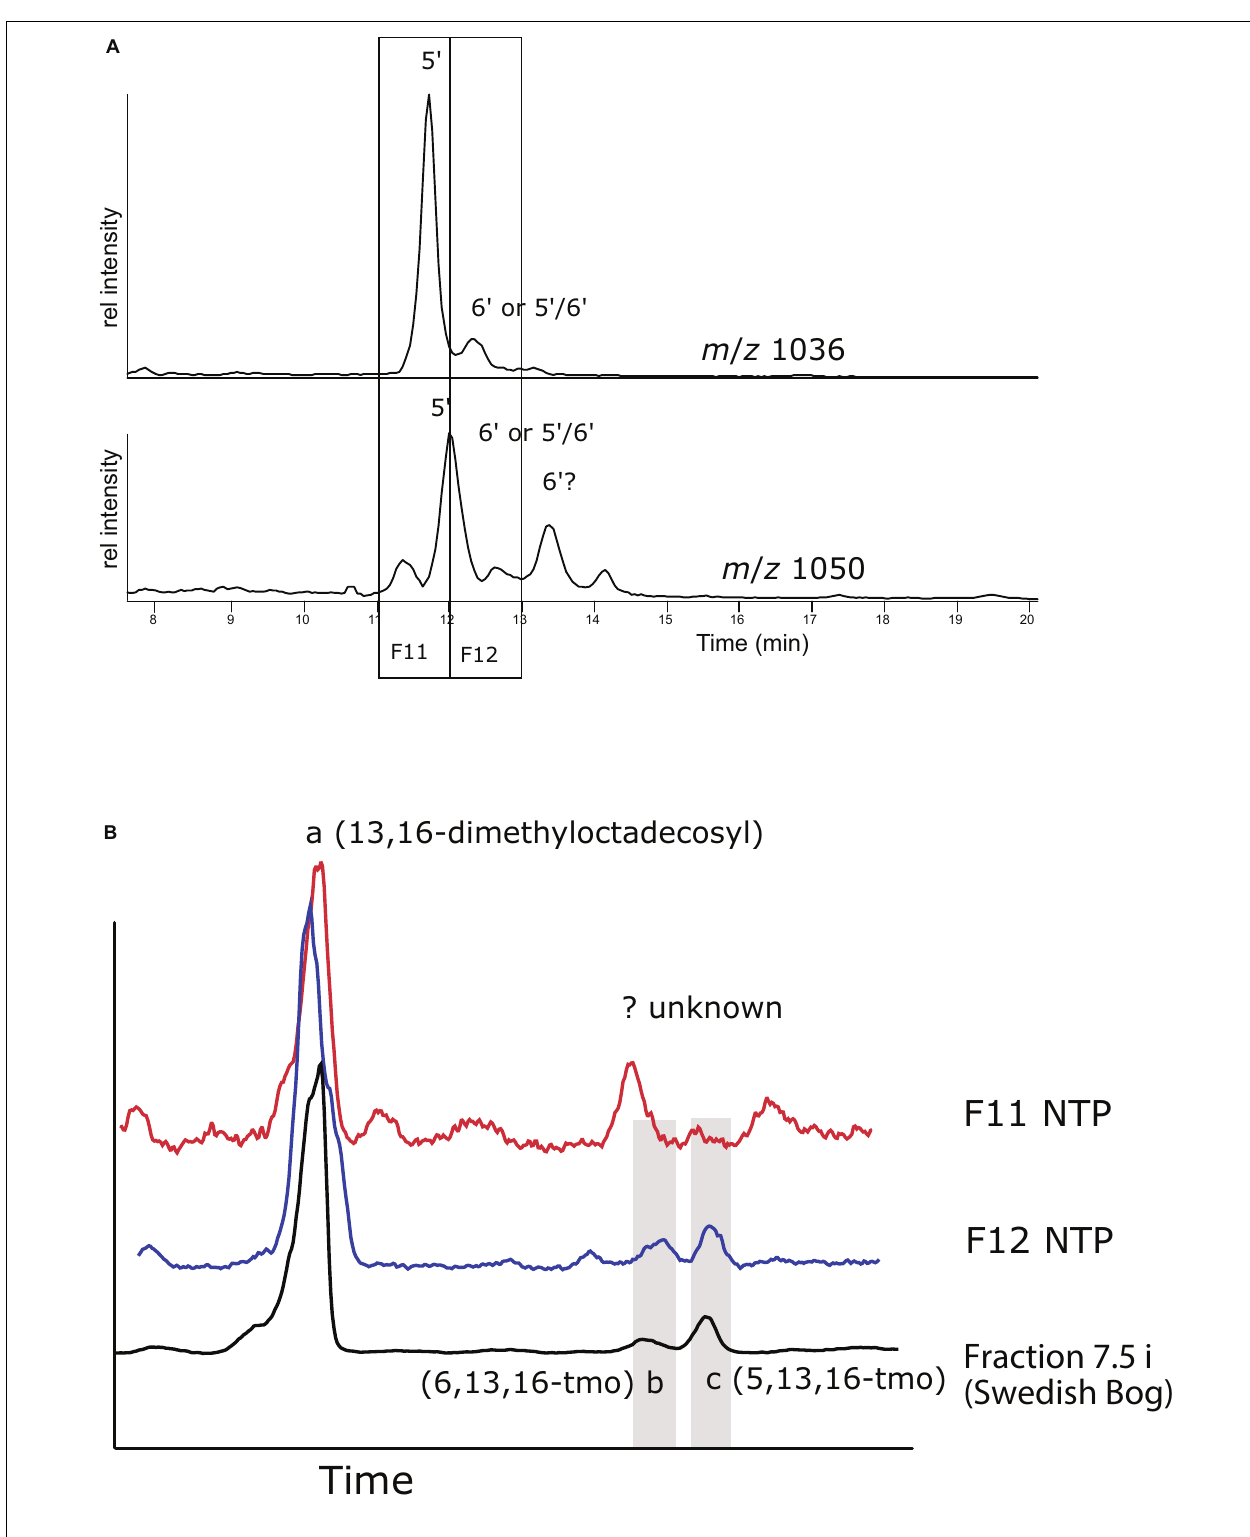
FIGURE 7 | (A) Reverse phase HPLC-MS ion chromatograms showing the distribution of m / z 1036 and m / z 1050 isomers in the NTP lake sediment extract. Numbers indicate the likely position of the methyl group on the isomers. (B) GC-MS total ion chromatogram (TIC) from ether cleaved and hydrogenated HPLC fractions eluting between 11–12 and 12–13 min, compared with the TIC of the 7.5 min fraction from the Swedish peat bog (cf. Figure 6 ). The positions of 5,13,16 (b)- and 6,13,16-trimethyloctasanyl as identified in Figure 6 are